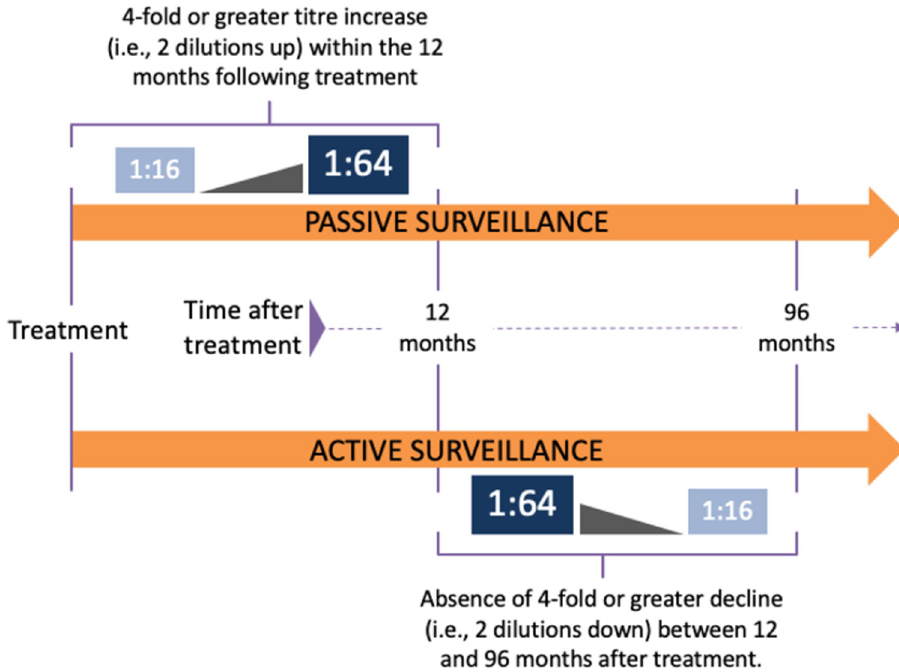
Fig 1. Definition of recurrence in the passive and active surveillance